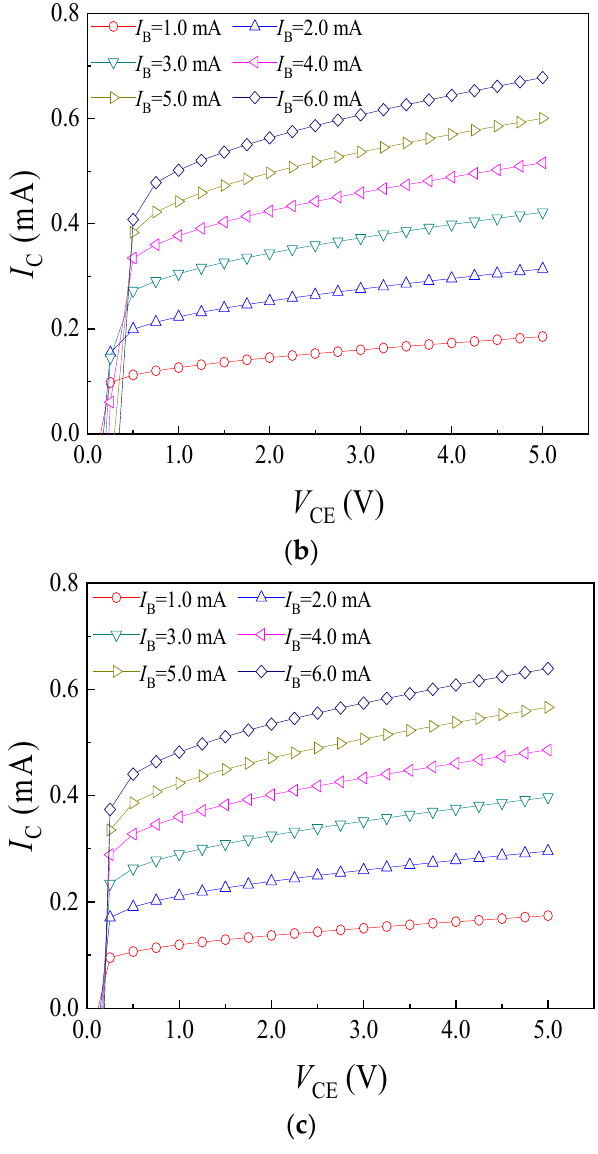
Figure 3. I C - V CE characteristic curves of the SMSTs. ( a ) Sample 1#; ( b ) sample 2#; ( c ) sample